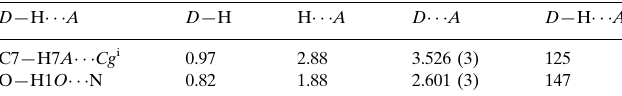
Hydrogen-bond geometry (A˚ , (cid:2) ). D —H (cid:1)(cid:1)(cid:1)